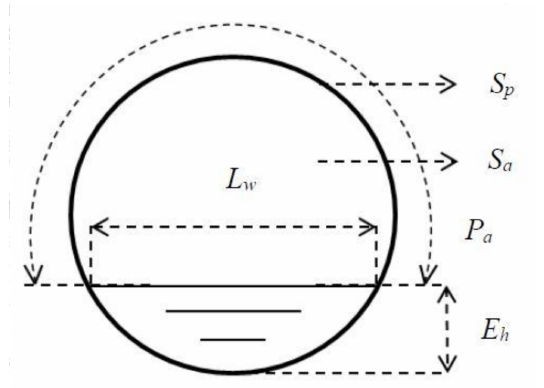
Figure 6. Geometric parameters of a cross section of the pipe with the presence of